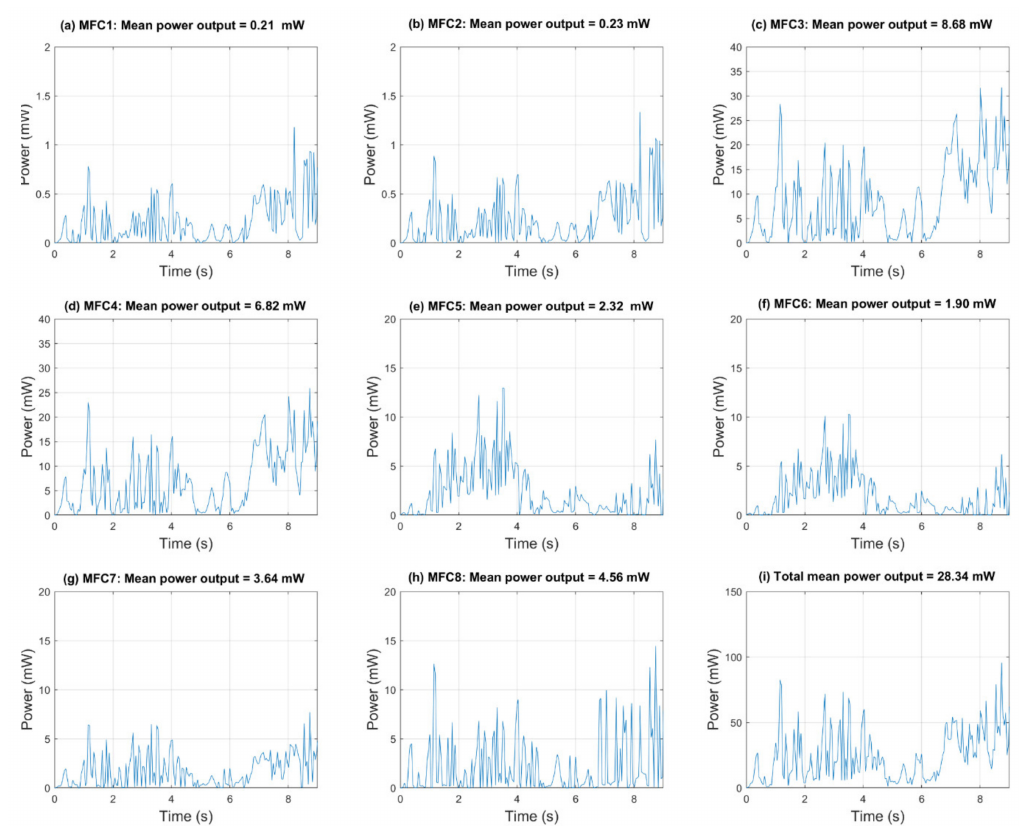
Figure 9. Power output calculated from 8 MFC piezoelectric